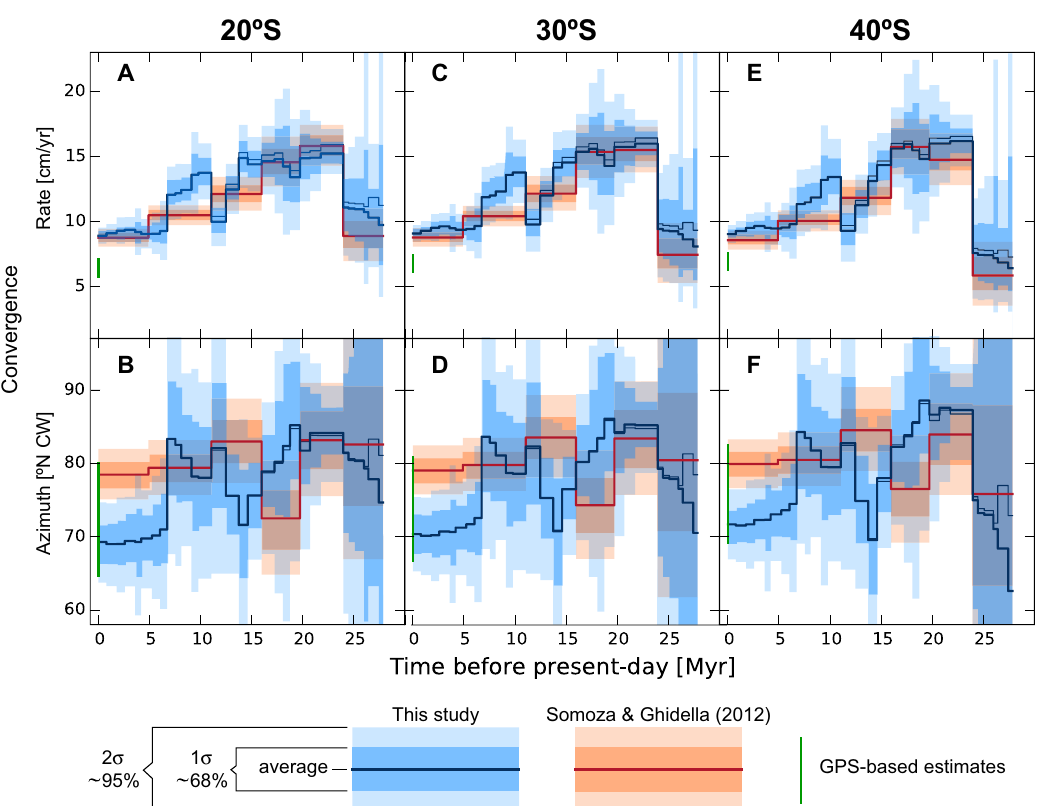
Fig. 2 Variation of Nazca/South America convergence rate and azimuth at different latitudes along the Andean trench for the last 30 Million years. A Convergence rate at 20°S from the study of Somoza and Ghidella (2012; ref. 17 ) in red and our study in blue. Convergence is inferred from an ensemble of one million samples of the Euler vectors (see Methods) drawn from the nominal values and associated covariances. Solid lines show the ensemble average, while polygons show the one sigma ( ∼ 68%) and two sigma ( ∼ 95%) con fi dence intervals (as shown in the legend of the fi gure). B Azimuth of convergence at 20°S for the same reconstructions shown in A . C , D Same as A , B , but calculated at 30°S. E , F Same as A , B , but calculated at 40°S. Thin blue line is for an alternative model that includes the relative motion between West and East Antarctica 40,41 . Green lines show the present-day rate and azimuth of convergence derived from various GPS-measured velocities 72 – 74